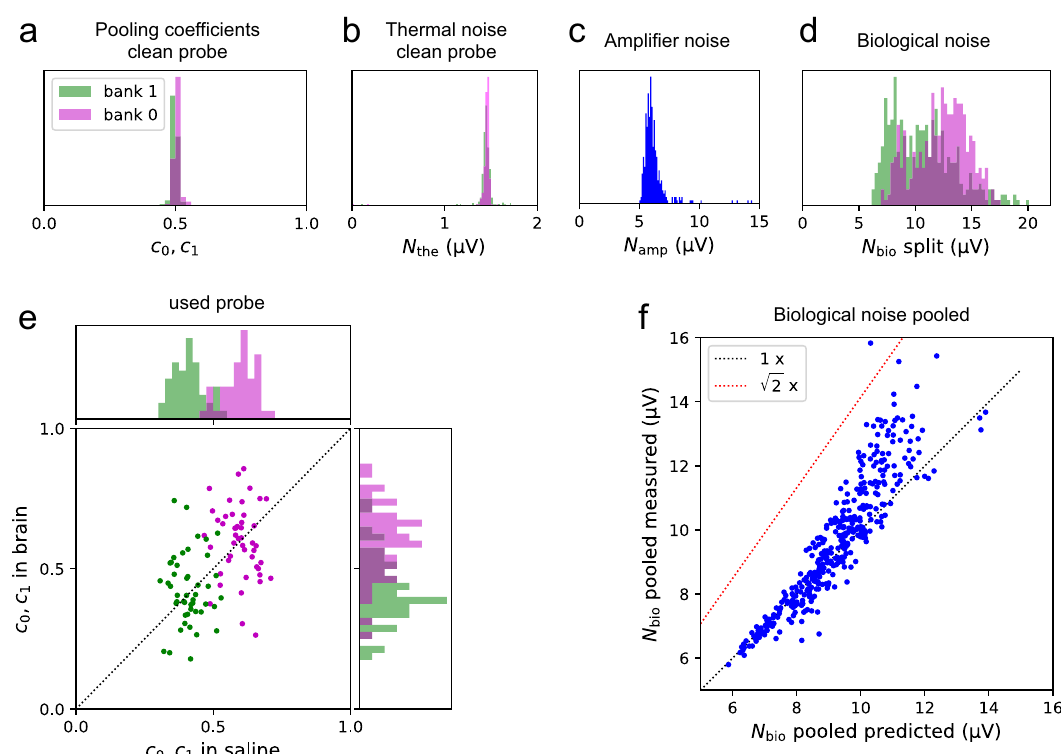
Fig. 4 Pooling of signal and noise with the Neuropixels 1.0 device. a Pooling coef fi cients on a pristine probe measured in saline, histogram across all sites in banks 0 (red) and 1 (green). b Thermal noise (RMS) during split recording in standard saline, histogram across all sites in banks 0 and 1. c Ampli fi er noise (RMS), histogram across all 383 wires. d Biological noise (RMS) during brain recordings, histogram across all sites in banks 0 and 1. e Pooling coef fi cients on a used probe, measured in saline (horizontal) vs in brain (vertical). 47 pairs of sites in banks 0 and 1 with suitable action potentials. f Biological noise in a pooled recording measured in brain (vertical) vs the prediction derived from assuming uncorrelated noise at the two sites. `1 x': ffiffiffi p identity. ` 2 x': expectation for perfectly correlated